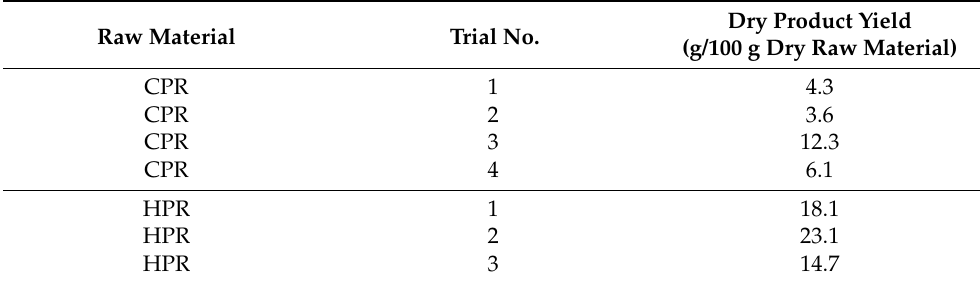
Table 5. Dry powder yield of the protein end products CPR-1 to CPR-4 and HPR-1 to